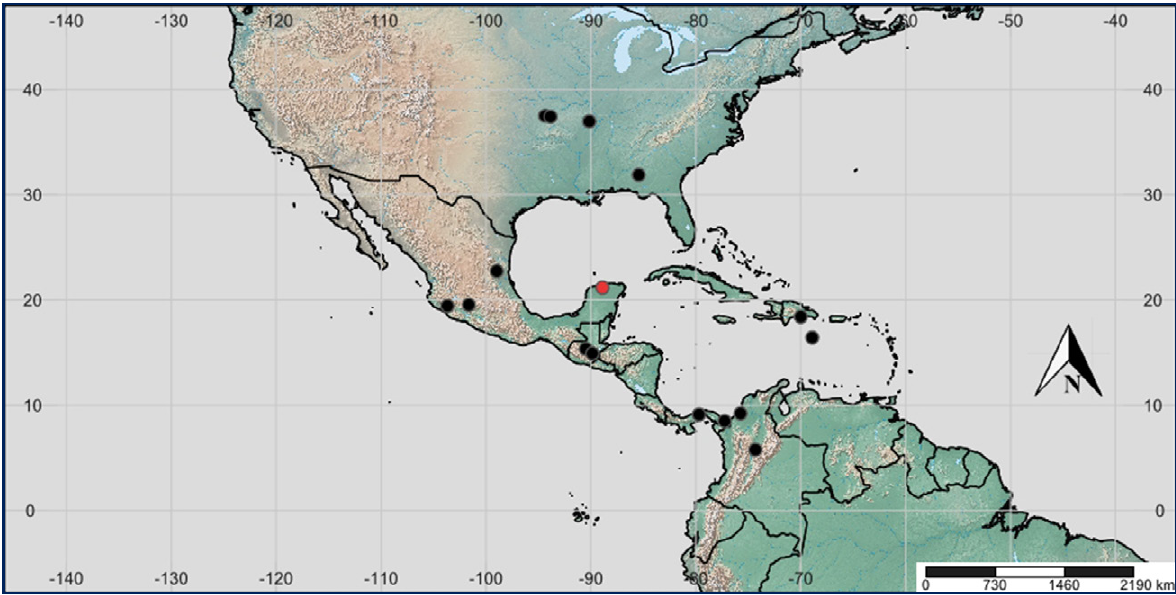
Figure 4. Distribution map of Persicaria glabra . Black circles = previously known distribution (Tropicos.org); red circle = new record in the Yucatan Peninsula,